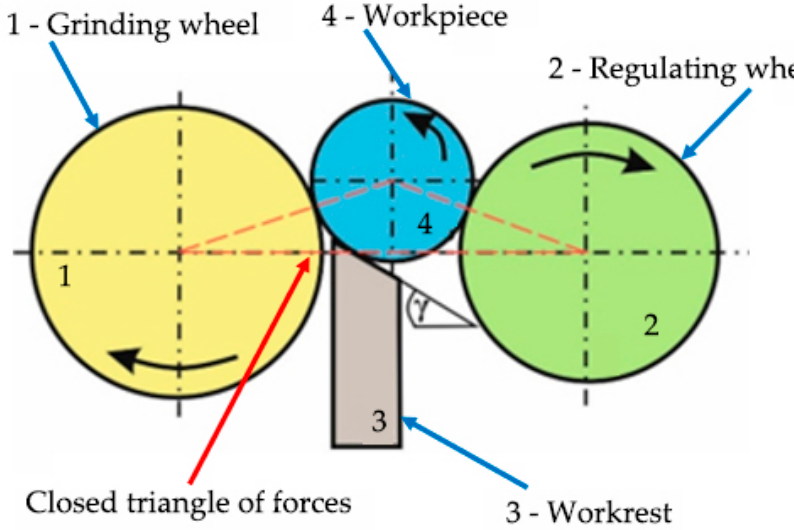
Figure 1. Centerless grinding technology—horizontal type.